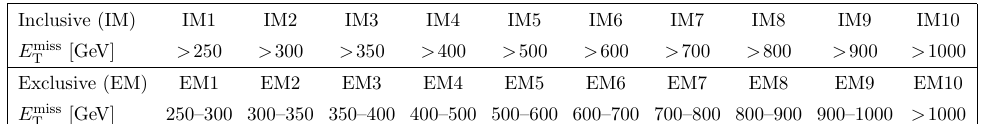
Table 1 . Inclusive (IM1{IM10) and exclusive (EM1{EM10) signal regions with increasing E miss thresholds from 250 GeV to 1000 GeV. In the case of IM10 and EM10, both signal regions contain the same selected events in data. In the case of the IM10 signal region, the background predictions are computed considering only data and simulated events with E miss background prediction is obtained from (cid:12)tting the full E miss described in section 6.